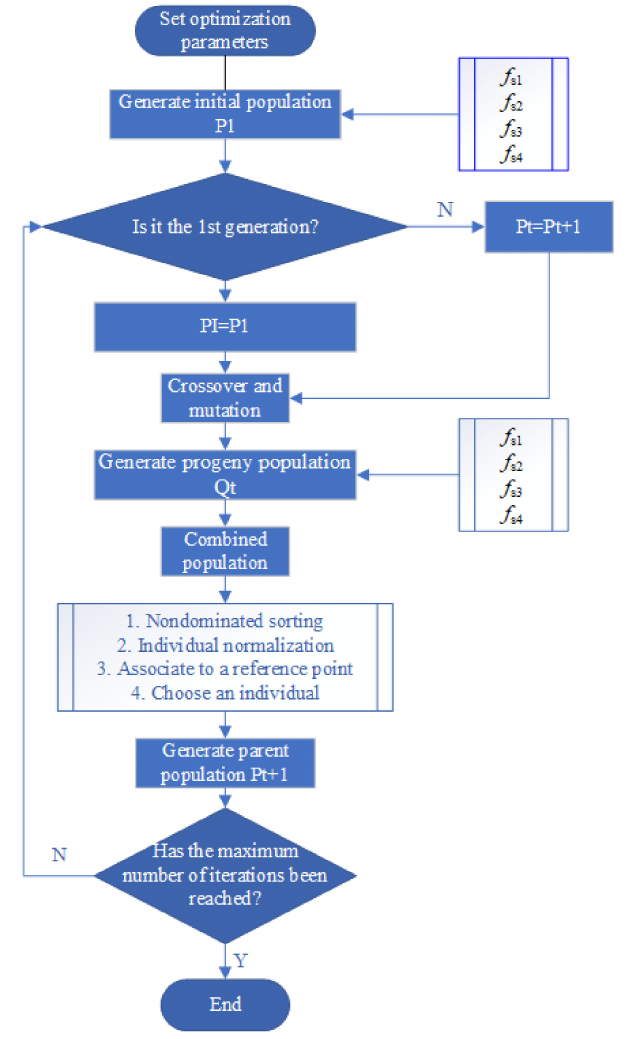
Figure 6. Optimization process of surrogate-assisted